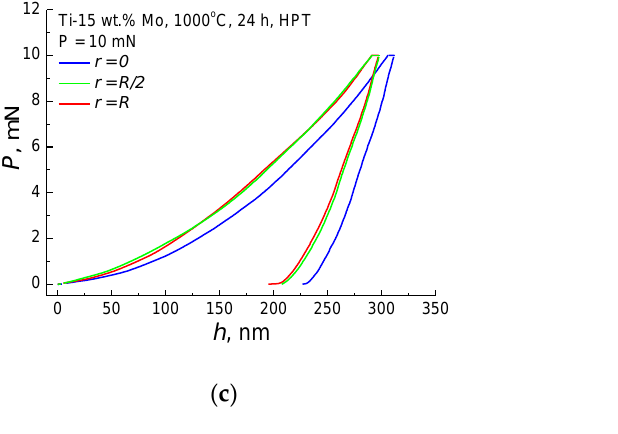
Figure 7. P – h diagrams ( P is the magnitude of the load, h is the depth of the imprint) for the Ti – 15 wt.% Mo alloy in the center of the disc ( r = R 0 ), in the middle of radius ( r = R 1/2 ), and at the edge of the sample ( r = R 1 ): ( a , b ) annealed at 1000 °C for 24 h; ( c , d ) annealed and subjected to HPT. Loads ( a , c ) P = 10 mN and ( b , d ) P = 200 mN.